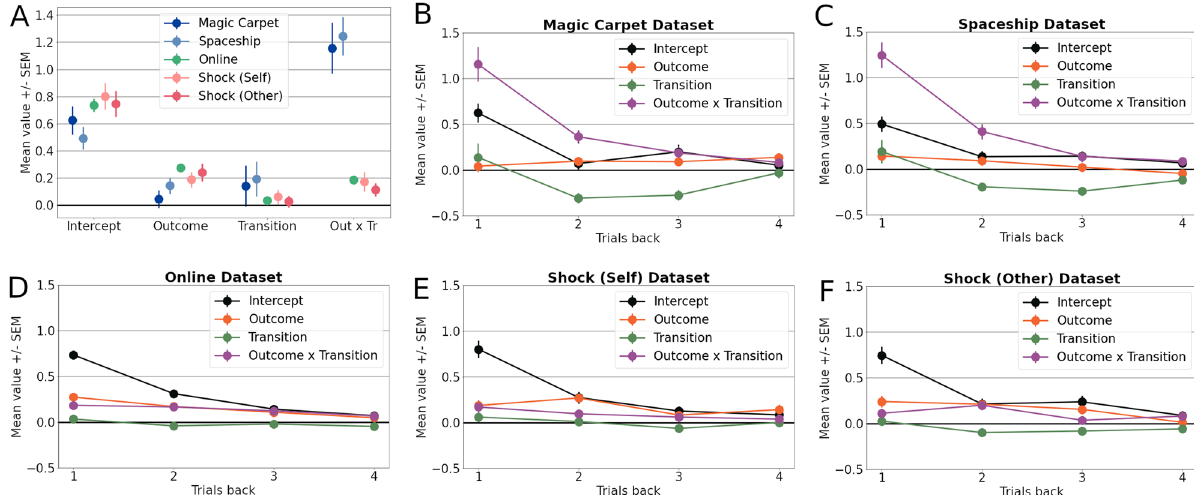
Figure 3. Logistic regression analyses. Regression analysis of first-stage actions based on the previous four trials. ( A ) Regression coefficients for the intercept, main effects of outcome and transition, and outcome- transition interaction only on the preceding trial across the different datasets. ( B – F ) Each subplot shows the coefficients for one dataset on all four preceding